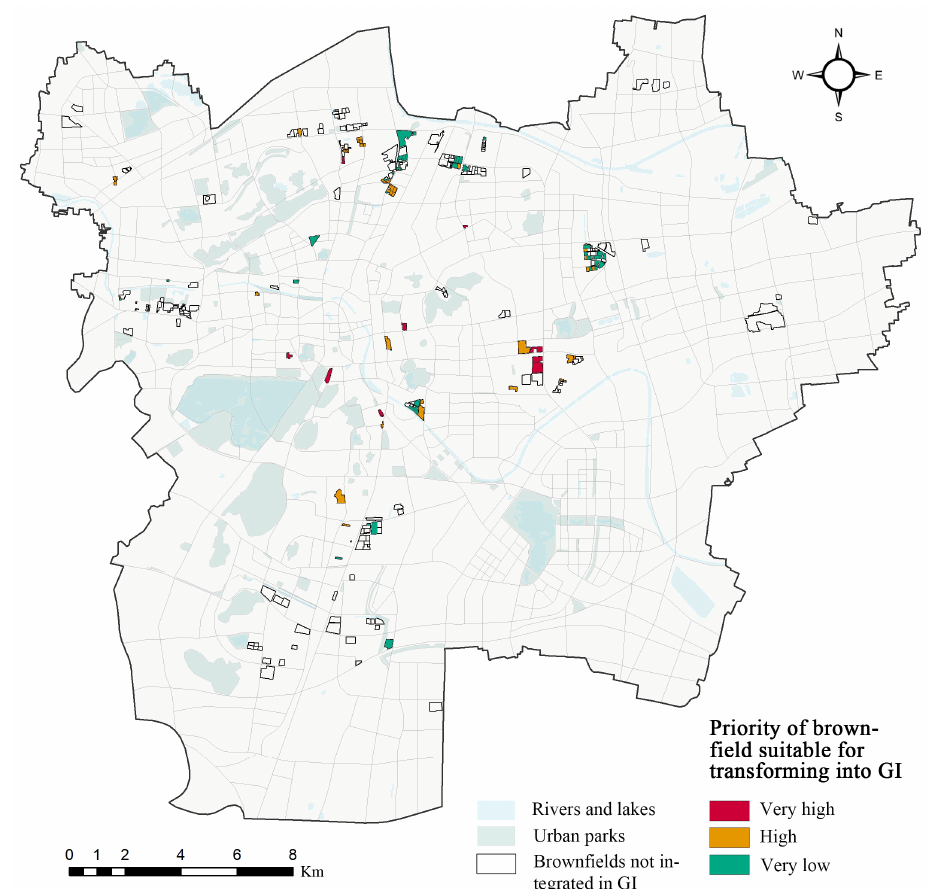
Figure 9. Priority of brownfields catering for GI.